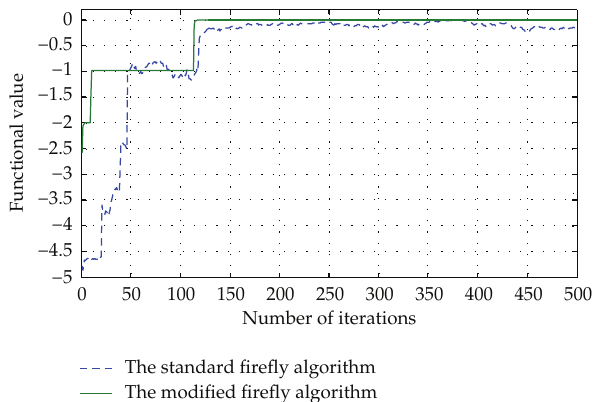
Figure 1: Simulation result of the first test